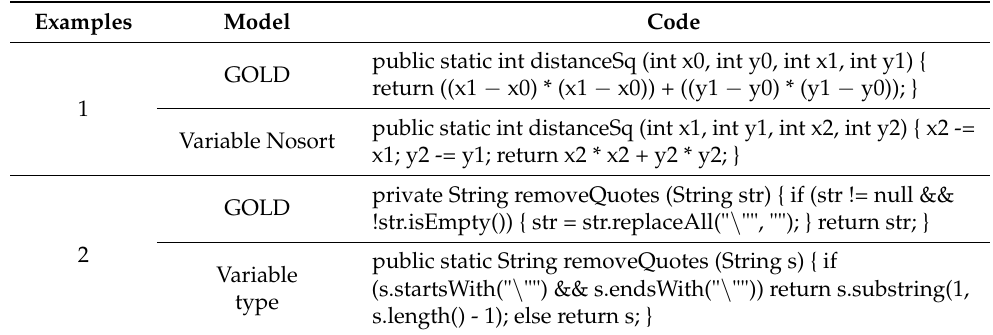
Table 10. Special examples of code generation with code